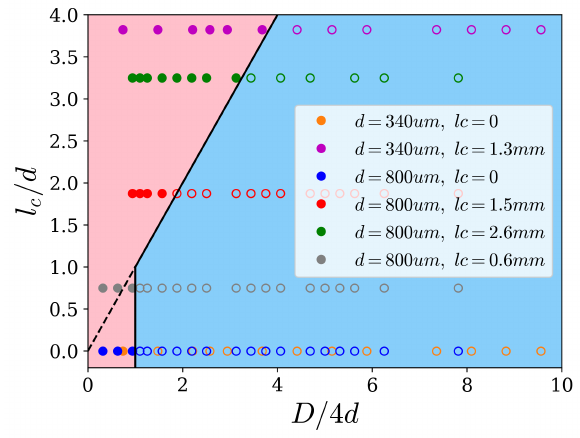
Figure 2. Threshold of flowability depending on the cohesion l c , the size of the grains d and the diameter of the orifice D . The pink region is the non-flowing zone, and the blue region is the flowing zone. Empty symbols correspond to flowing experiments, and full symbols correspond to non flowing experiments.